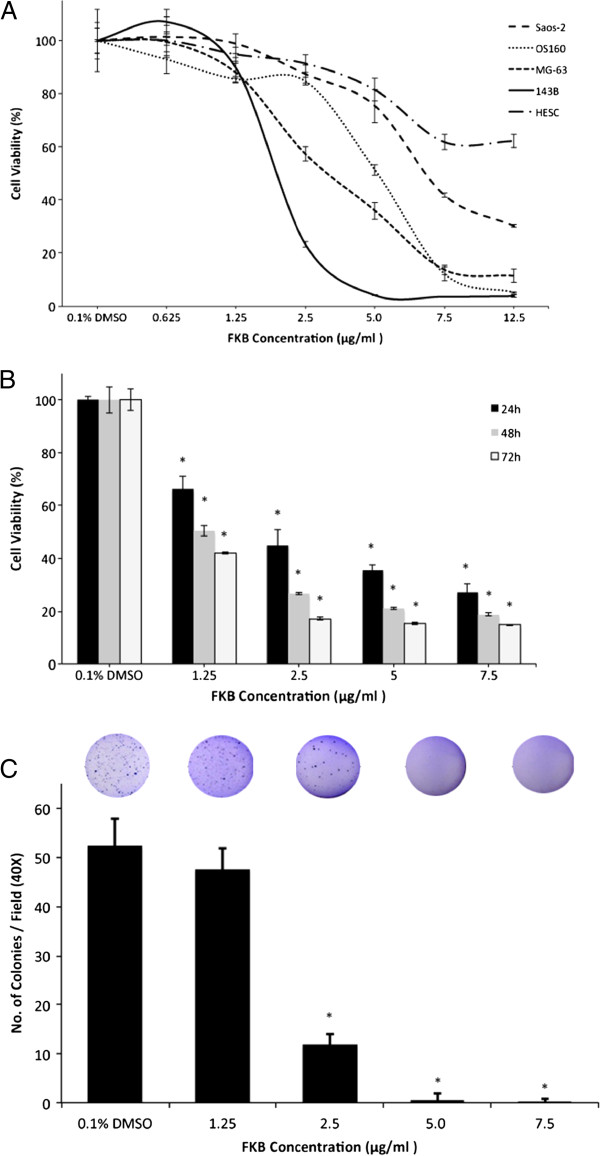
Antiproliferative effect of FKB on OS cells. A, Four OS cell lines and fibroblast cell line (HESC) were used and cells were treated with FKB at the indicated concentration in the figure for 72 h, and cell viabilities were measured by MTT assay. B, 143B cells were treated with indicated concentrations for 24, 48 or 72 h. C, anchorage-independent colony formation assay showed significantly decreased number of colonies formed by 143B cells treated with FKB compared with control group; inset, representative photography of soft agar colonies at 14 days after cell seeding. An asterisk (*) indicates a significant difference in comparison with the control group (p<0.05).